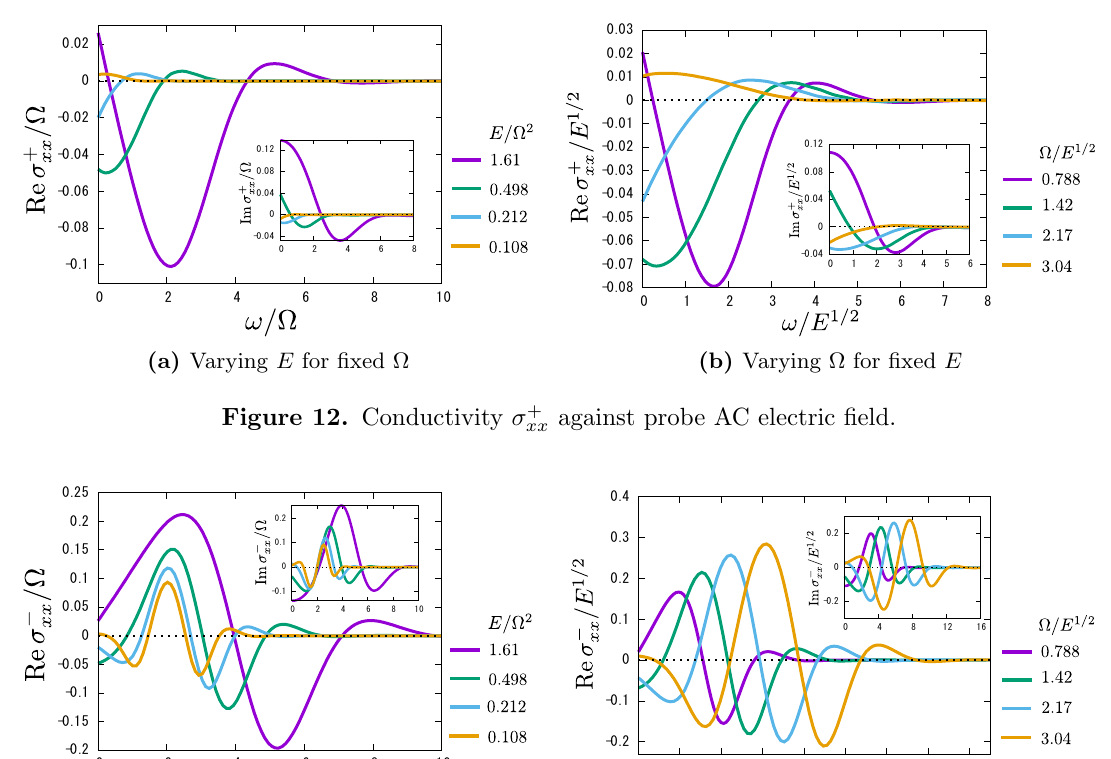
against probe AC electric xx